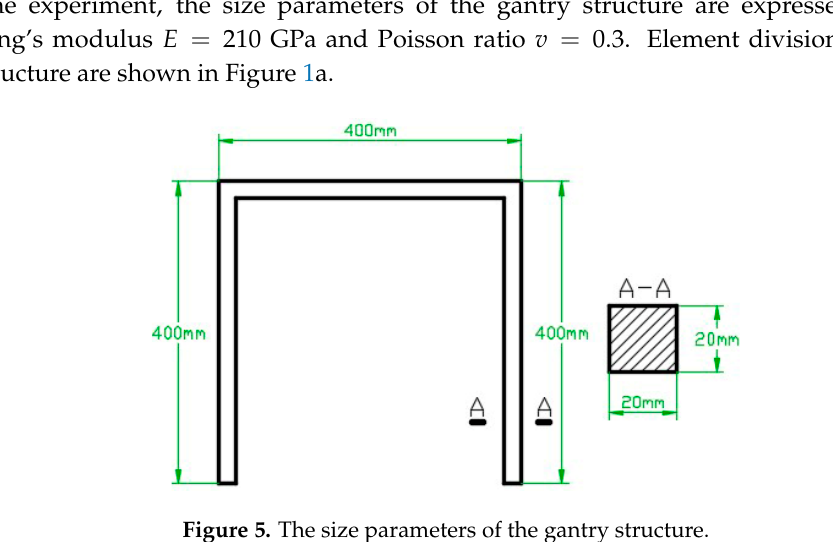
Figure 5. The size parameters of the gantry structure.